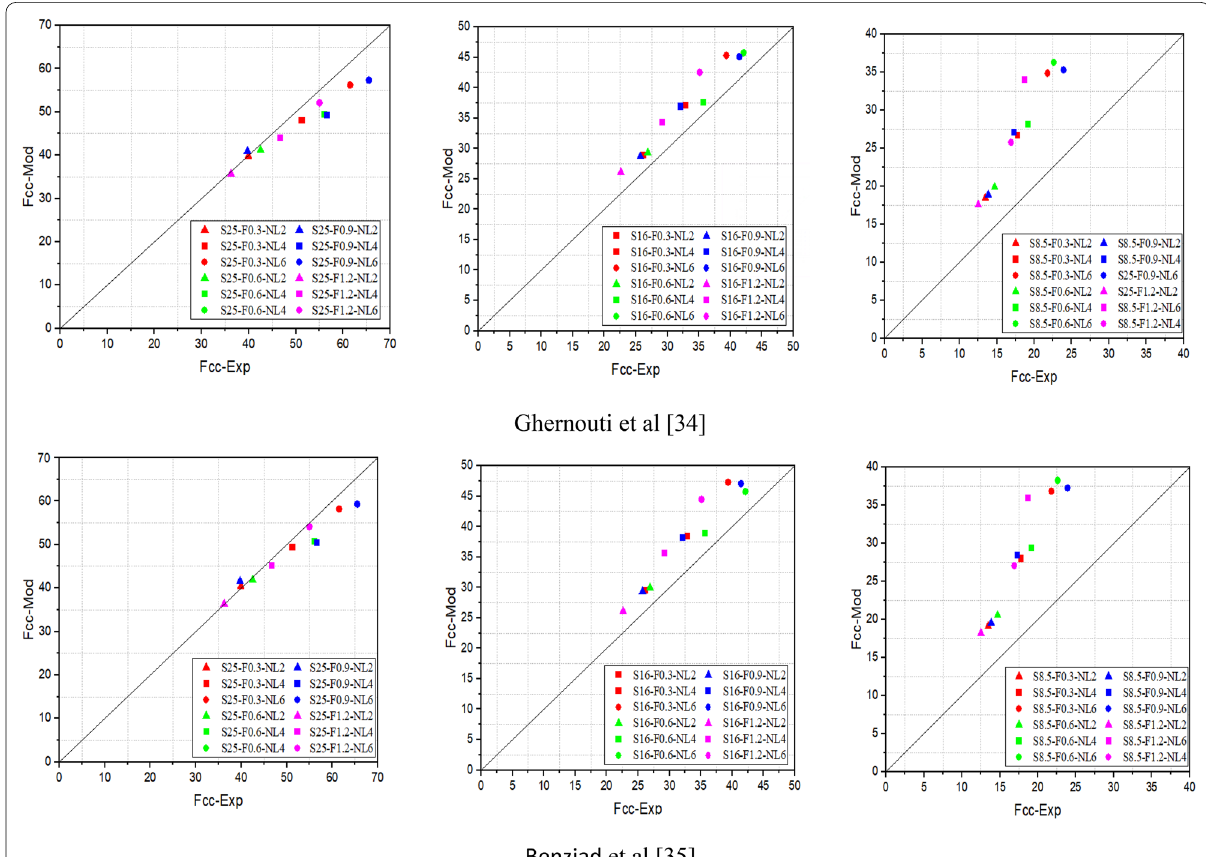
Fig. 12 Comparison of the experimental results with the prediction models (ultimate